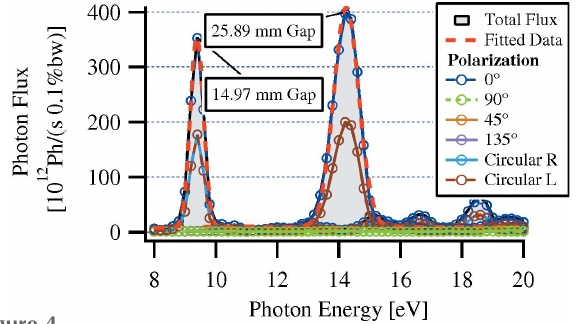
Figure 4 Radiation spectra calculated for various polarization modes in SRW for two configurations of the quasiperiodic RADIA model. The configurations are at different gaps and are both in planar polarization ( (cid:4) E = (cid:4) L = 0 mm).